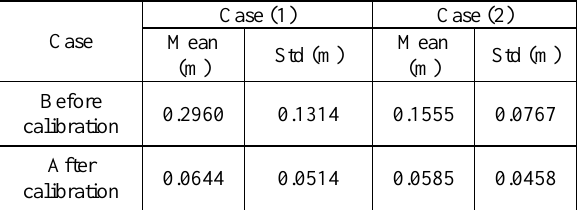
Table 2. The mean and the standard deviation of the distance between the LIDAR and images-driven point clouds before the calibration and after the calibration for testing the distance